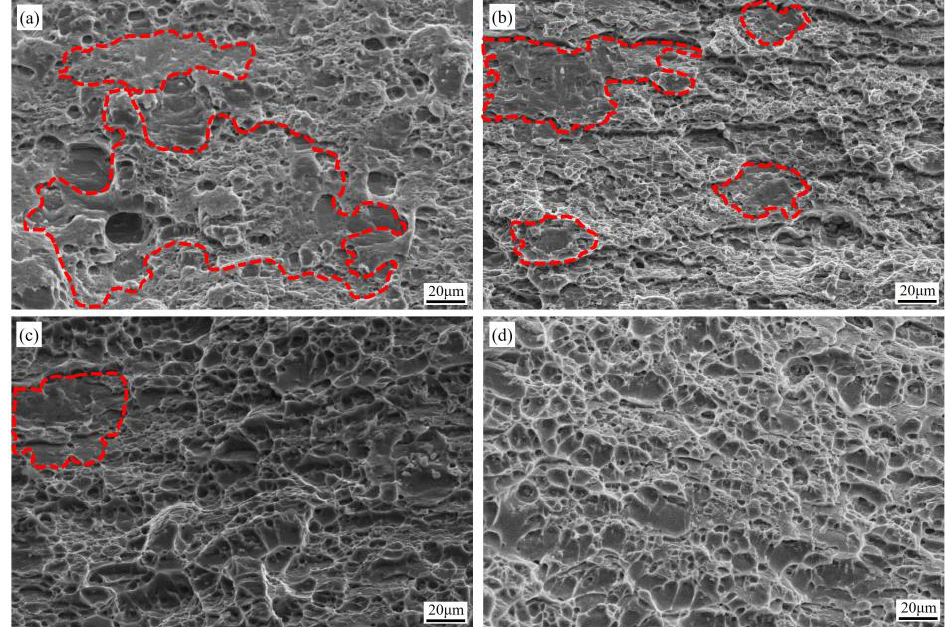
Figure 7. Fracture surface morphologies of the W-state alloy under uniaxial tension at ( a ) 298 K, ( b ) 218 K, ( c ) 138 K, and ( d ) 77 K.